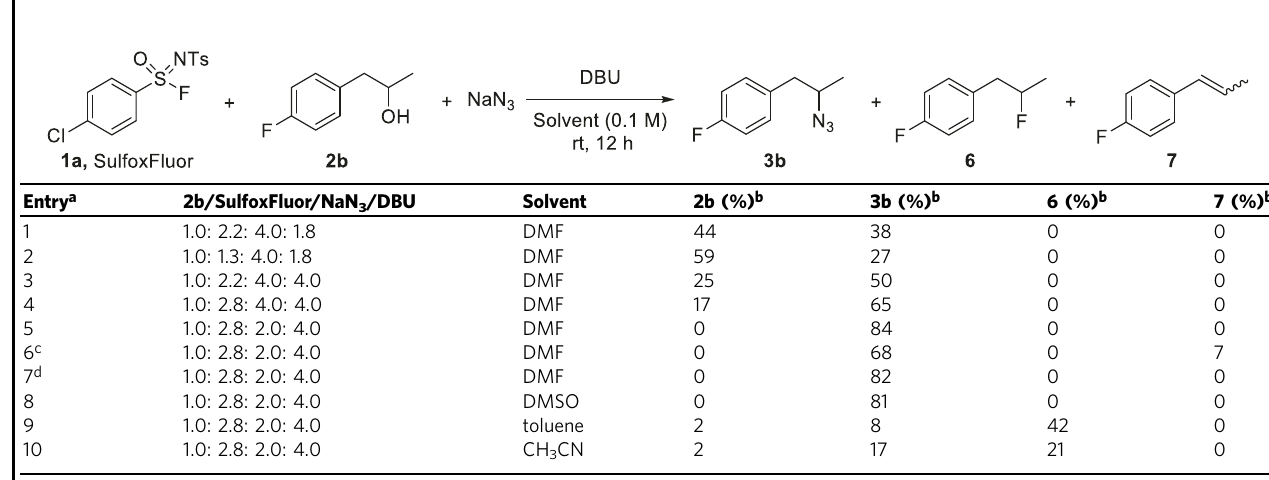
Table 2 Screening of reaction conditions for secondary alcohol 2b.